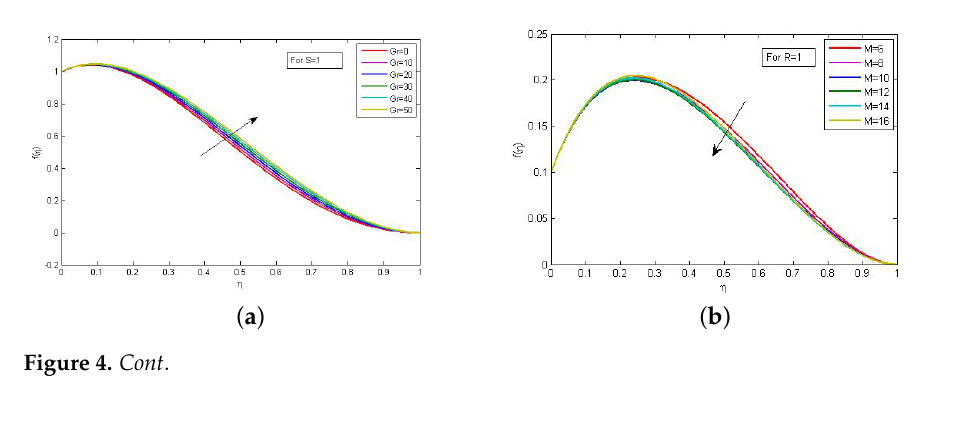
f (cid:48) ( η ) variation with varying M for cases: (b) R = 1.0 (b) R = 0.0. and (f) R = 0.5. The